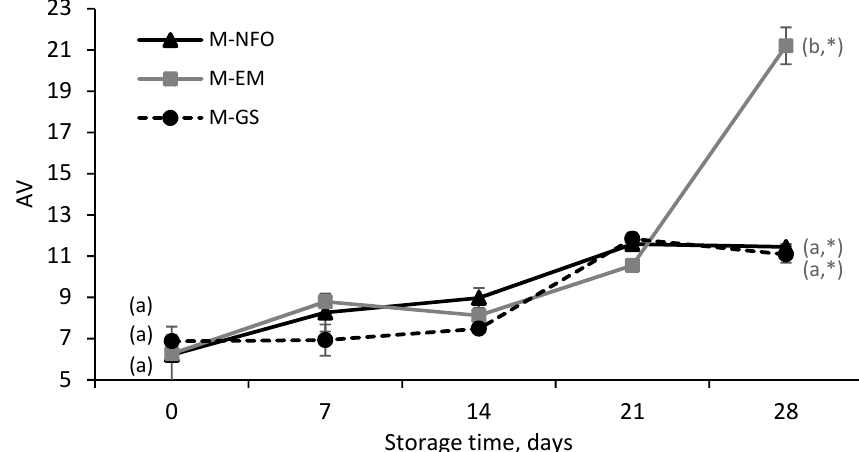
Figure 6. P-anisidine value (AV) of low-fat fortified mayonnaise enriched with neat fish oil (M-NFO), Figure 6. P ‐ anisidine value (AV) of low ‐ fat fortified mayonnaise enriched with neat fish oil (M ‐ NFO), emulsified fish oil (M-EM) or microencapsulated fish oil (M-GS) over storage time at 25 ◦ C. Means within emulsified fish oil (M ‐ EM) or microencapsulated fish oil (M ‐ GS) over storage time at 25 °C. Means the same sampling point followed by a letter, a-c, indicates statistical di ff erences ( p ≤ 0.05). Means within within the same sampling point followed by a letter, a ‐ c, indicates statistical differences ( p ≤ 0.05). the same sample followed by an asterisk, *, indicates statistical di ff erences ( p ≤ 0.05) between day 0 and Means within the same sample followed by an asterisk, *, indicates statistical differences ( p ≤ 0.05) day between day 0 and day 28.